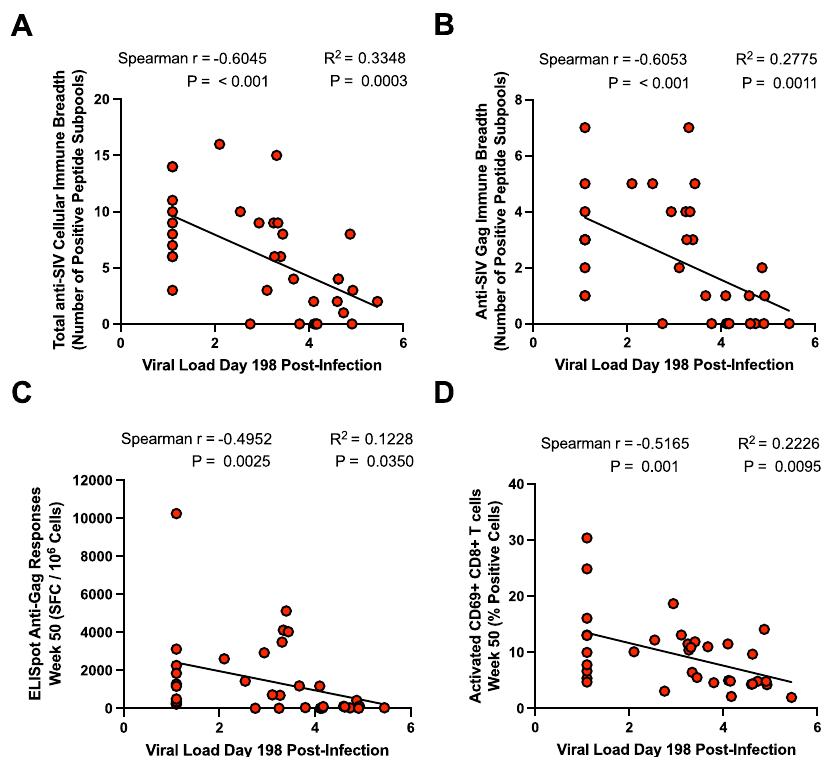
Fig. 5 Immune correlates of virologic control following antiretroviral therapy interruption. A – D Spearman correlation plots between total cellular anti-SIV immune breadth as determined by the number of positive subpools detected via IFN γ ELISpot ( A ), the total anti-Gag Immune breadth as determined by the number of Gag-positive subpools detected via IFN γ ELISpot ( B ), anti-Gag IFN γ ELISpot responses quanti fi ed as SFC/10 6 cells ( C ), frequency of activated (i.e., CD69 + ) anti-viral CD8 + T cells at week 50 post-infection ( D ), and the viral load determined at day 198 after ART interruption. Spearman r coef fi cients and P values are displayed above each correlation plot. R 2 values and best fi t lines are also displayed following an additional linear regression